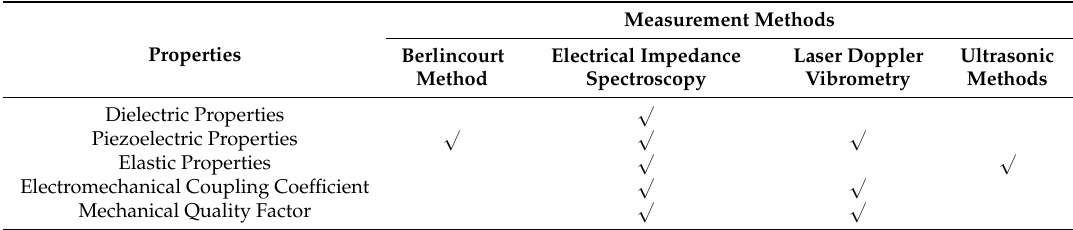
Table 1. Compatibility between piezocrystal properties and measurement